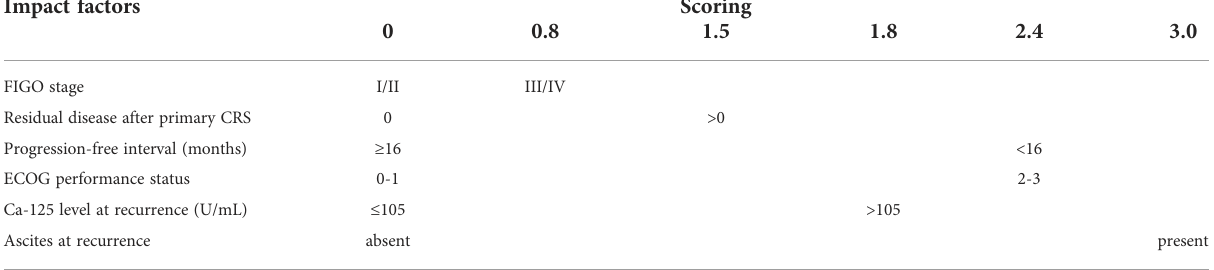
FIGO, Fe ́ de ́ ration Internationale de Gyne ́ cologie et d ’ Obste ́ trique; CRS, cytoreductive surgery; ECOG, Eastern Cooperative Oncology